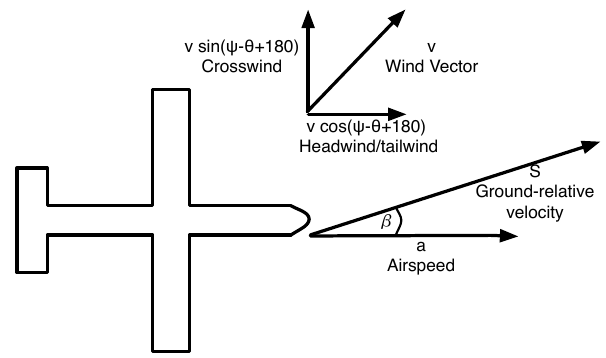
Fig. 1. Diagram showing the components affecting ground-relative movement of the UAS platform used in Eq. (1). The ground-relative velocity is the summation of the airspeed and plane relative wind vectors.